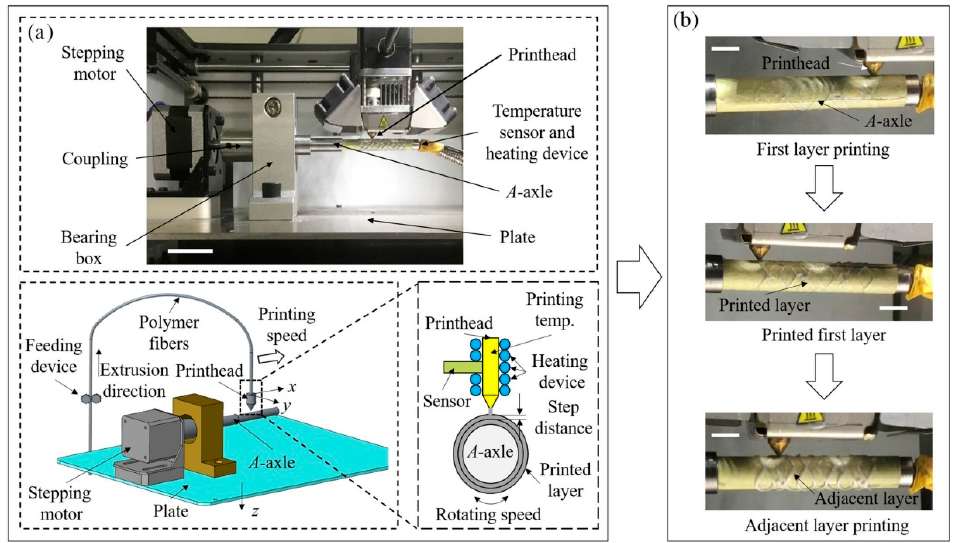
Figure 4. FDM processing of stents. ( a ) 3D printer machine and machine methodology. ( b ) Fabrication process [64], Copyright © 1999–2022 John Wiley & Sons, Inc.